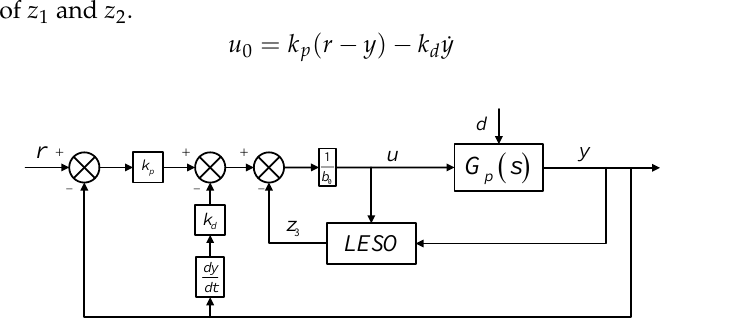
Figure 5. The Modified Second-order LADRC